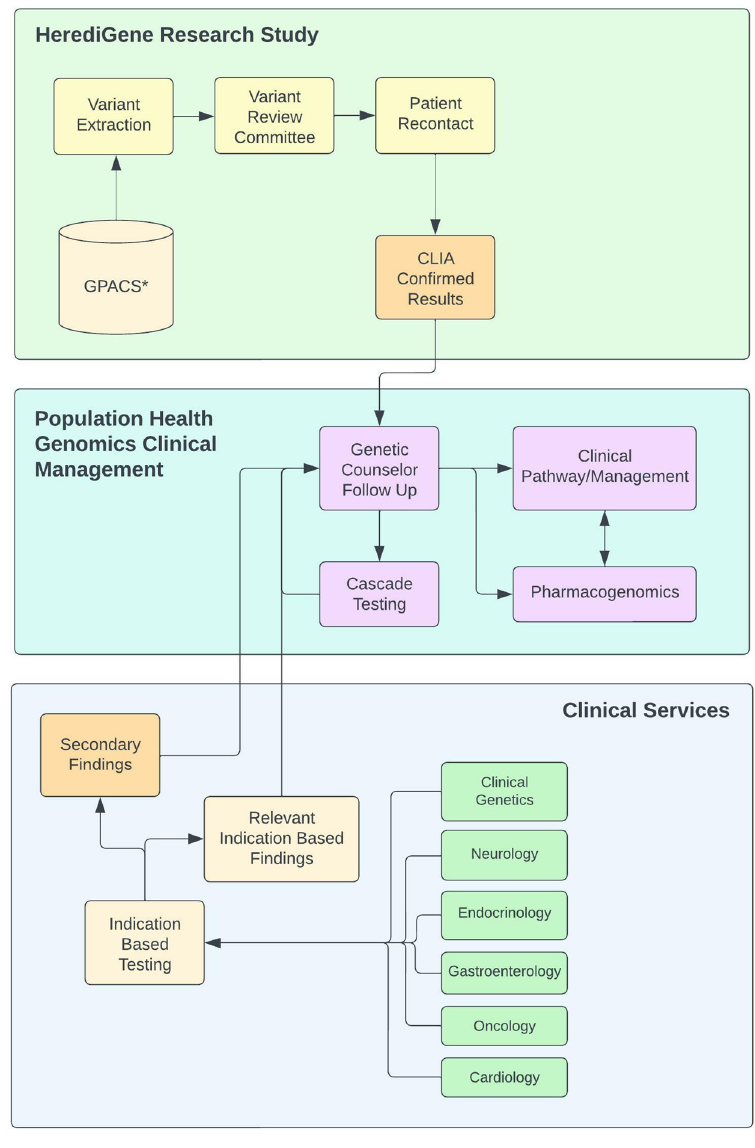
Figure 1. Diagram of population health genomics clinical workflow. * (GPACS) Genotype-Phenotype Archiving and Communication System.